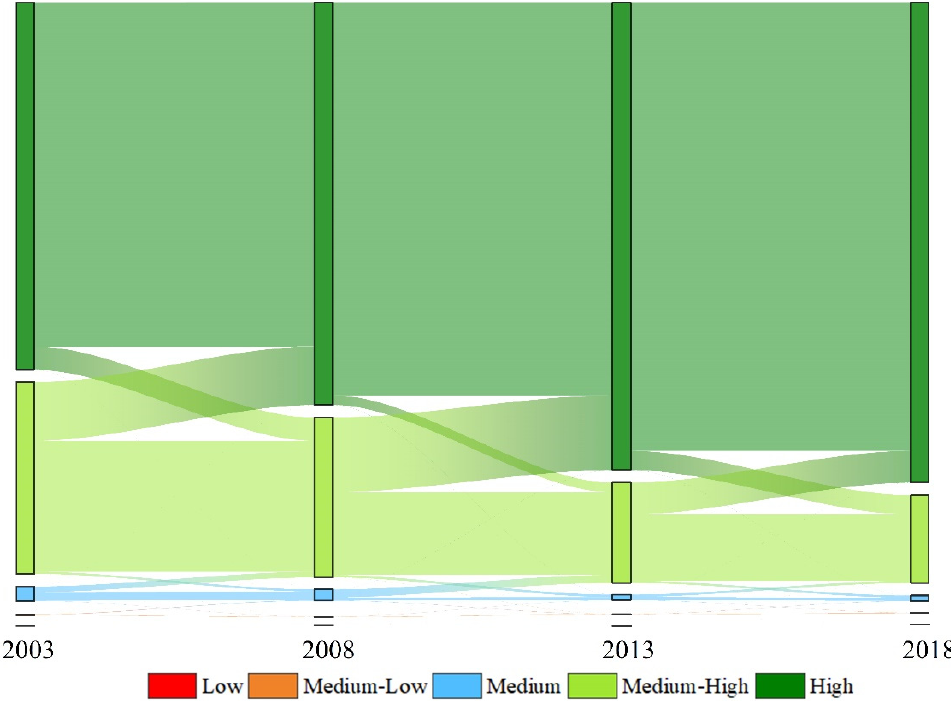
Figure 7. Sankey diagram of spatial variation of NDVI in the QBM, 2003–2018. Note: The width of color band is the percentage of different levels of NDVI.